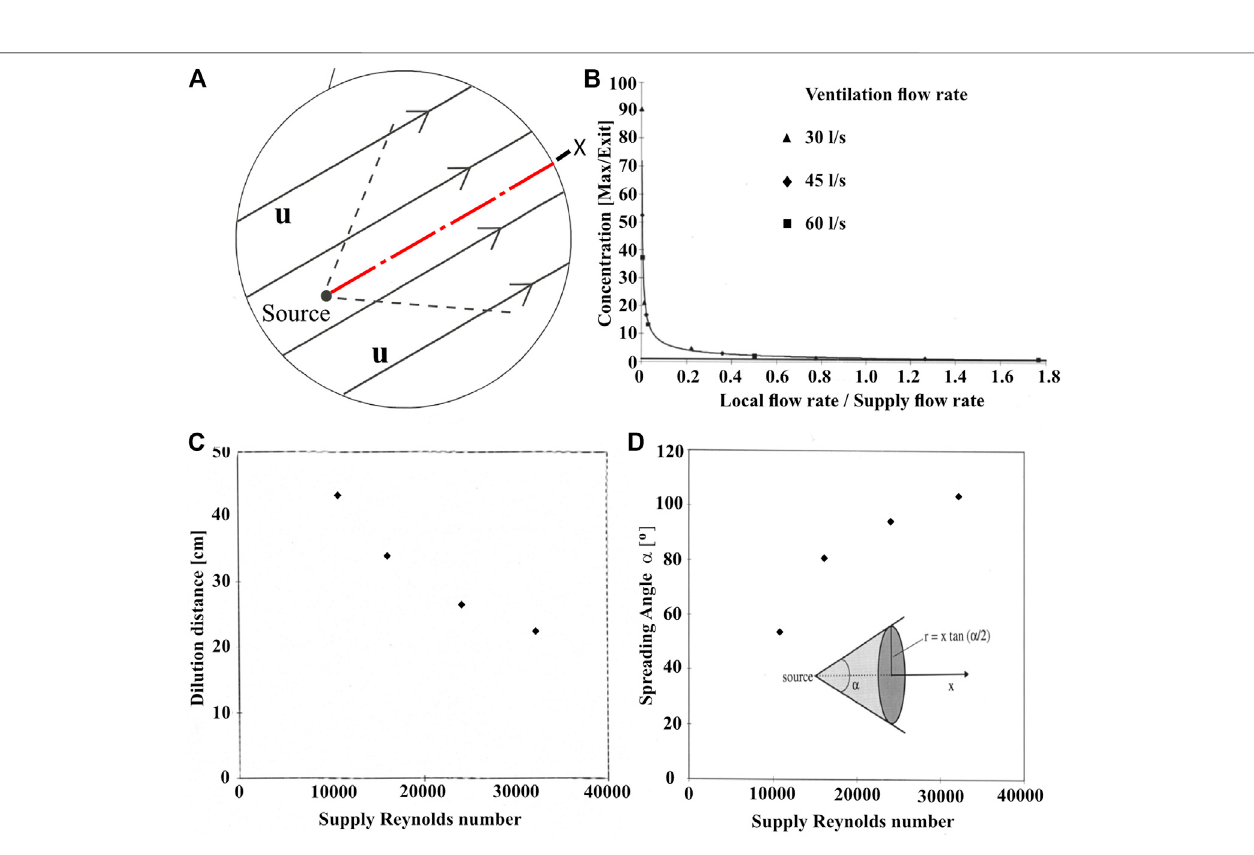
Frontiers in Built Environment |